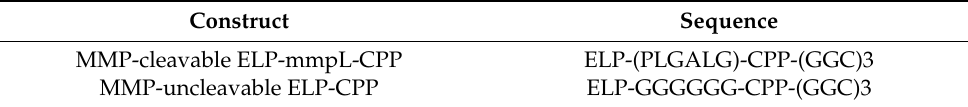
Table 1. Construct